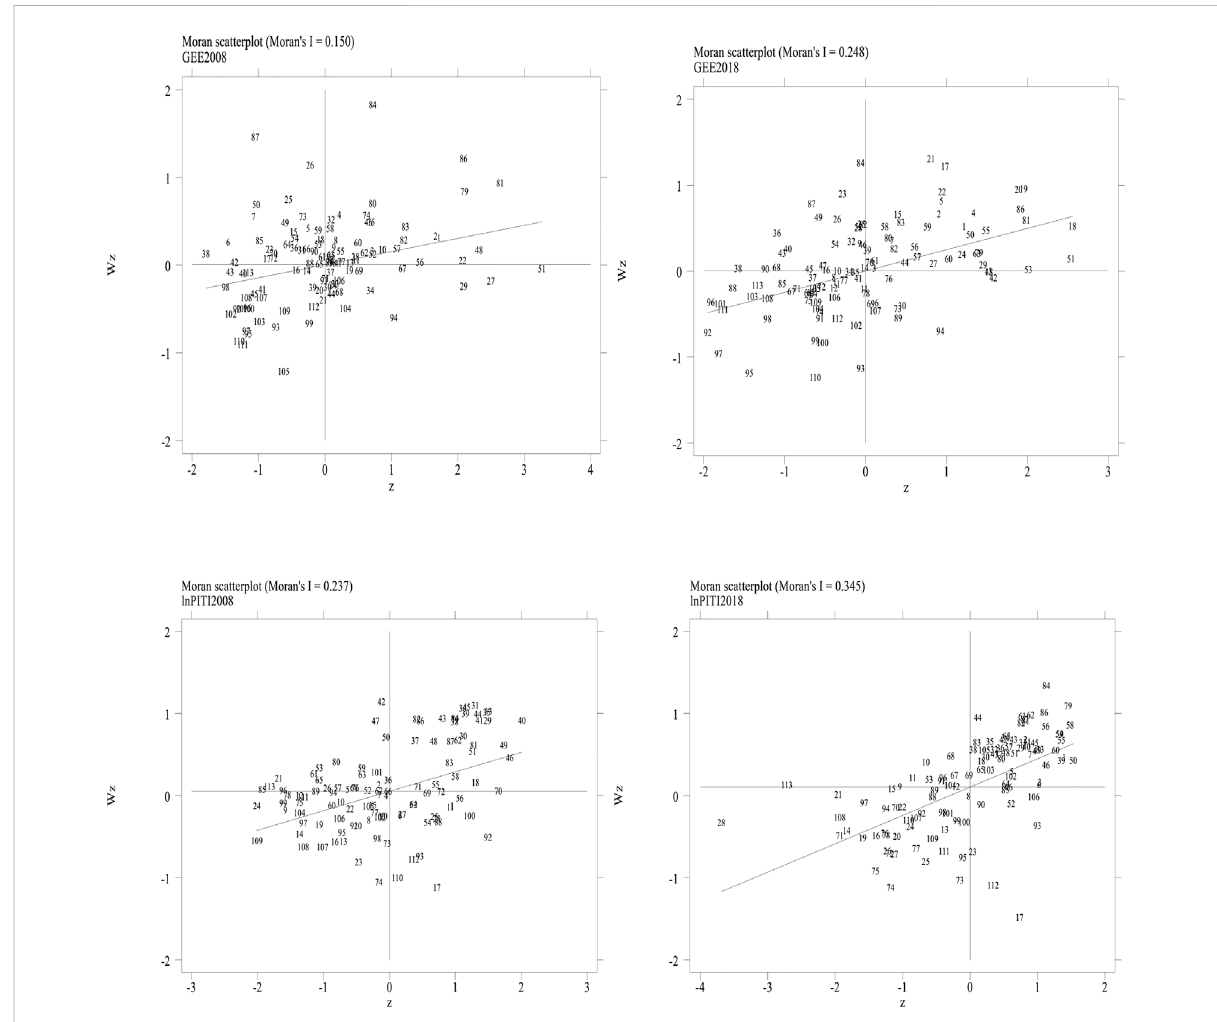
FIGURE 5 Local Moran scatter diagram of GEE and lnPITI.